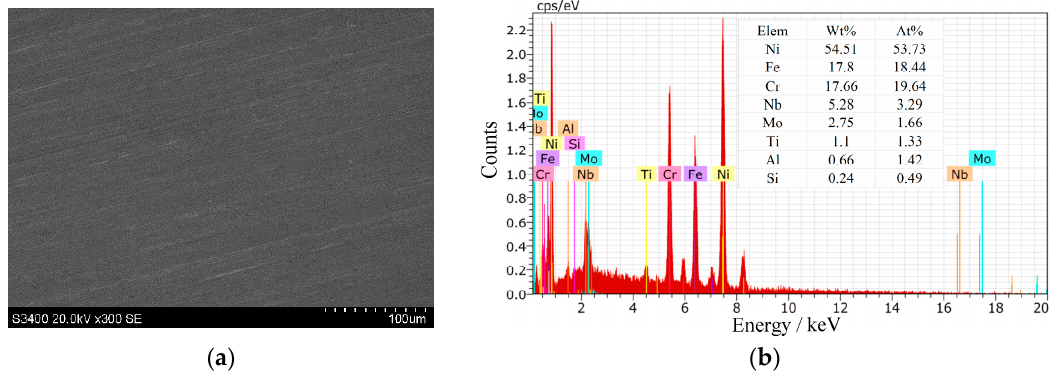
Figure 5. SEM and EDX results for the corroded specimen in a mixed solution of 106 g/L NaNO 3 and 30 g/L NaOH. ( a ) SEM image of the specimen surface; ( b ) EDX of machining products.